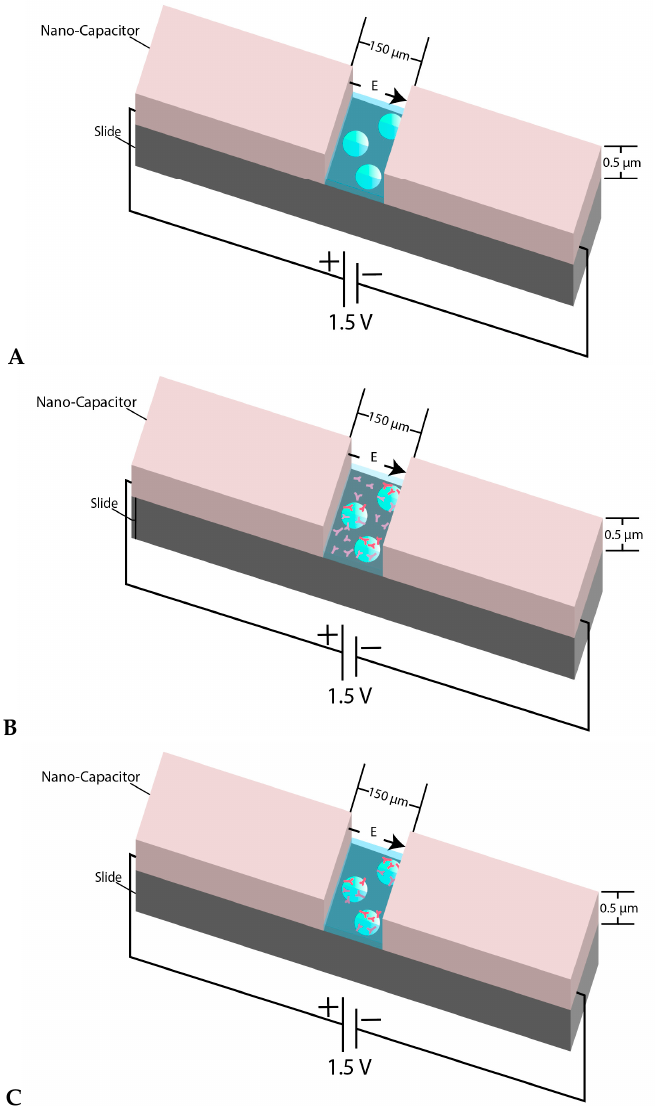
Figure 1. ( A ) View of the micron-sized capacitor built on a microscope slide. The space between two electrodes is 150 µm and the coating thickness is almost 0.5–0.55 µm. The behavior of microsphere plain beads was monitored inside the nanocapacitor’s gap in a kinesin free environment; ( B ) When the beads were mixed with kinesin and were immediately transferred between the nano-capacitor’s electrodes, we refer to the beads in such samples as “un-incubated beads”; ( C ) shows the schematic view of the experiment when the beads were mixed and incubated with kinesin before transferring into the capacitor’s gap. The beads in such samples are referred to as “incubated beads”. The figure’s components are not to scale.